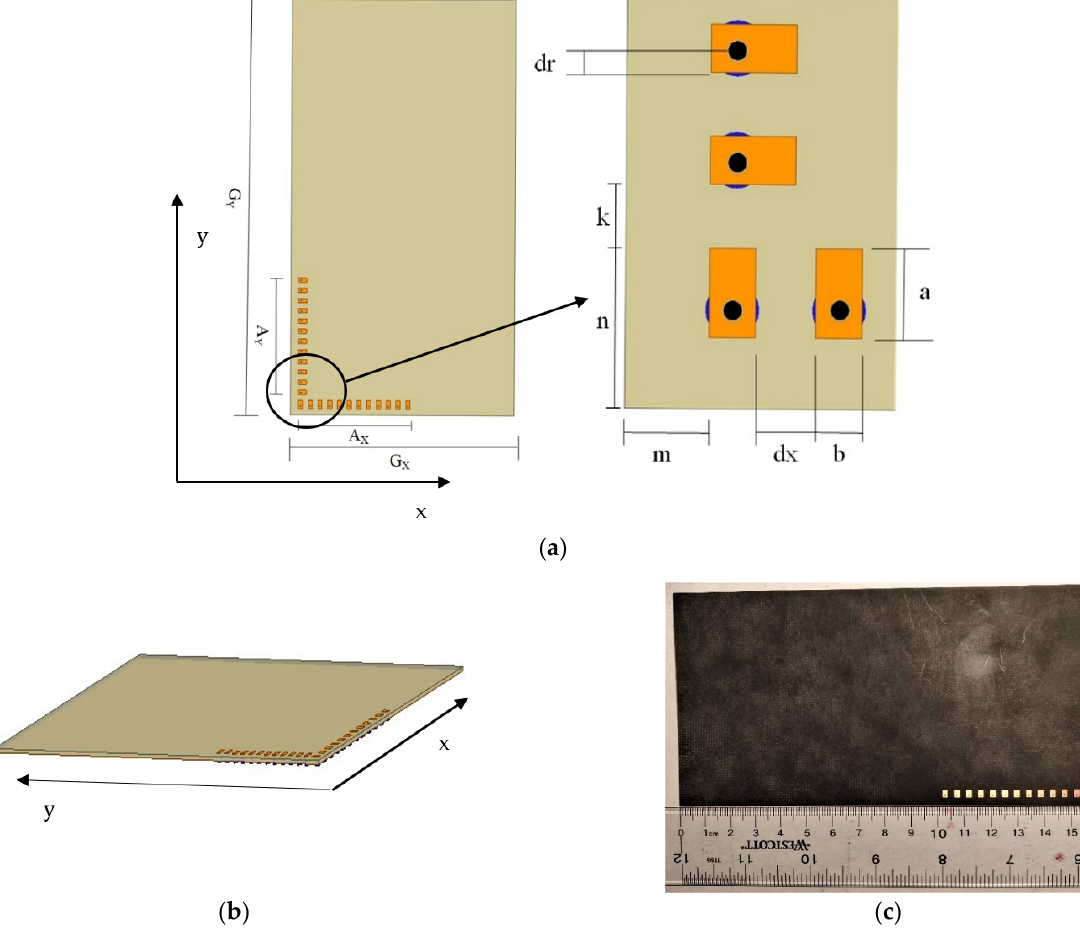
Figure 1. Geometry of the antenna arrays ( a ) top view, ( b ) 3D view, and ( c ) fabricated prototype.